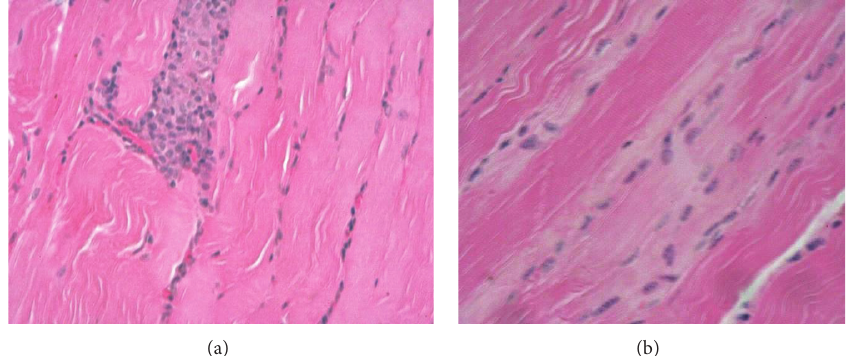
Figure 5: Muscular dystrophy. (a) Mononuclear infiltration replaced a damage muscular fiber, H&E, 160x. (b) Muscular nucleus proliferation in damage pale fibers in ewes. H&E, 80x.